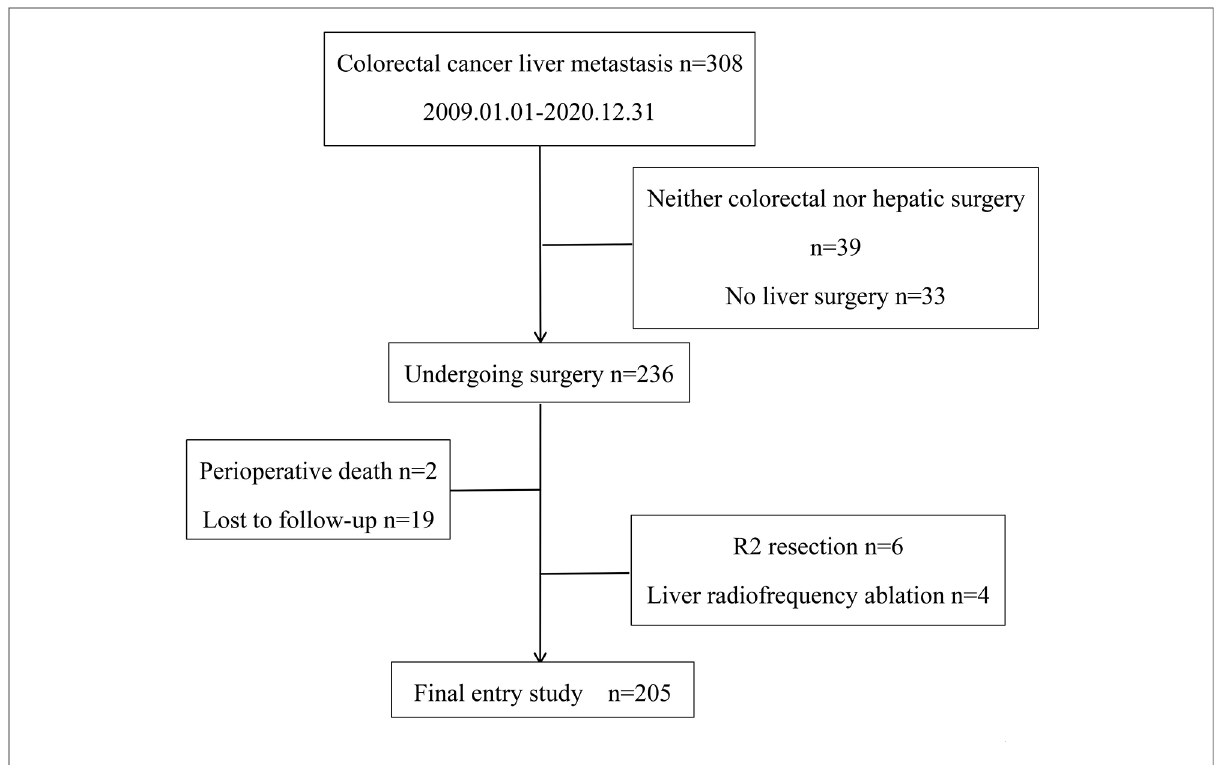
FIGURE 1 Patient inclusion and exclusion fl ow